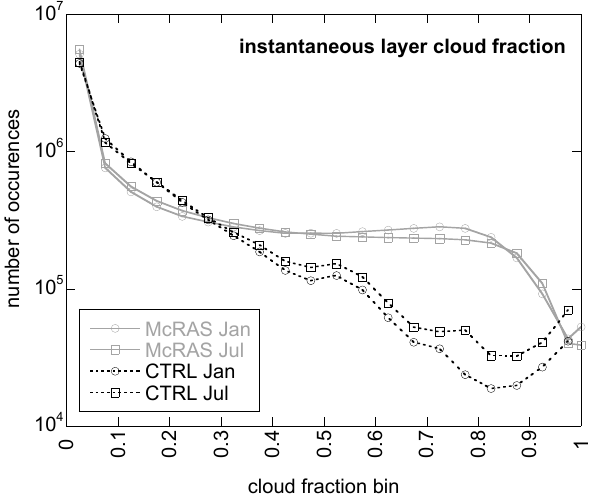
Fig. 10. Annually- and zonally-averaged total cloud fraction C tot (on a scale 0–100) for Exp. 2 and Exp. 4 cloud fraction overlap assumptions applied to CTL and McRAS-AC cloud schemes.